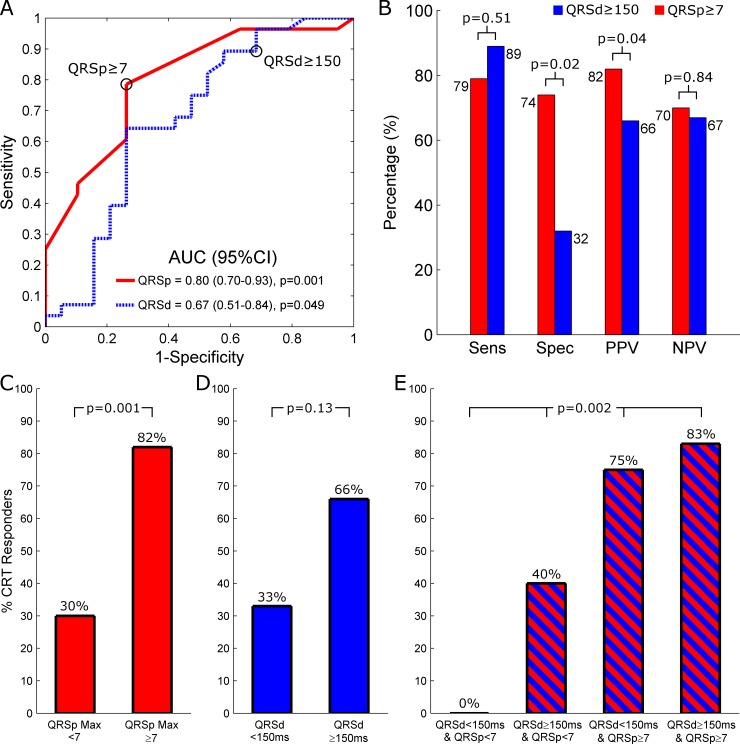
Performance of QRSp and QRSd in predicting CRT response (N = 47).(A) ROC curves for QRSp Max (red solid line) and QRSd (blue dashed line) as a predictor of CRT response. Black circles highlight the sensitivity and 1-specificity obtained by using a QRSp Max cutpoint ≥7 and a QRSd cutpoint ≥150ms. (B) Bar graphs comparing the prognostic performance of the QRSp Max and QRSd cut-points for identifying CRT responders. (C-E) Bar graphs comparing CRT responder rates between patients stratified by (C) the optimal QRSp Max cutpoint of ≥7, (D) the conventional QRSd cutpoint of ≥150ms, and (E) the combination of both these cutpoints. While nearly all patients with both QRS ≥150ms and QRSp ≥7 responded to CRT, there were no responders amongst patients with both a QRS <150ms and QRSp <7. AUC = area under the curve. 95% CI = 95% confidence interval. PPV = positive predictive value. NPV = negative predictive value.